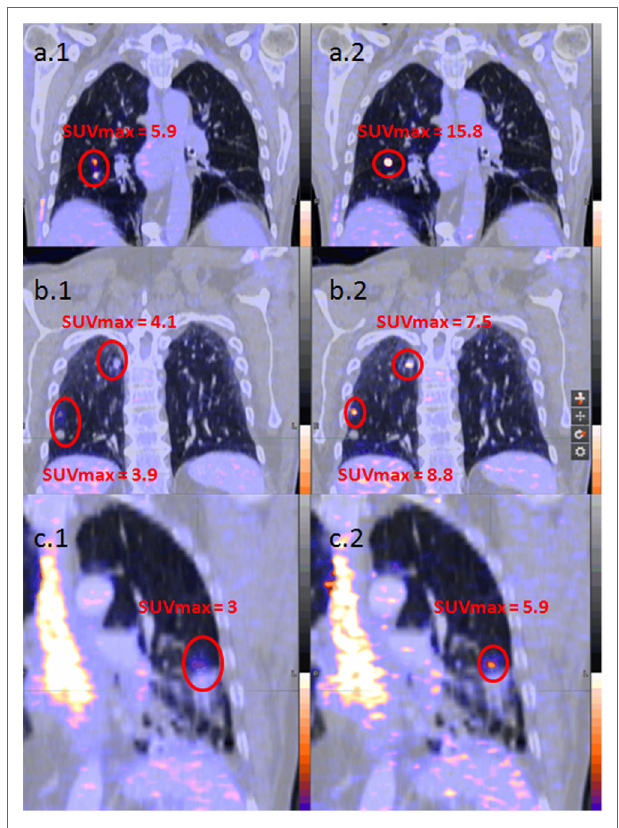
FigUre 4 | Examples of patient analysis [ (a) unique lesion, (b) multiple lesions, and (c) diffuse lesions; 1. left images without respiratory gating; 2. right images with respiratory